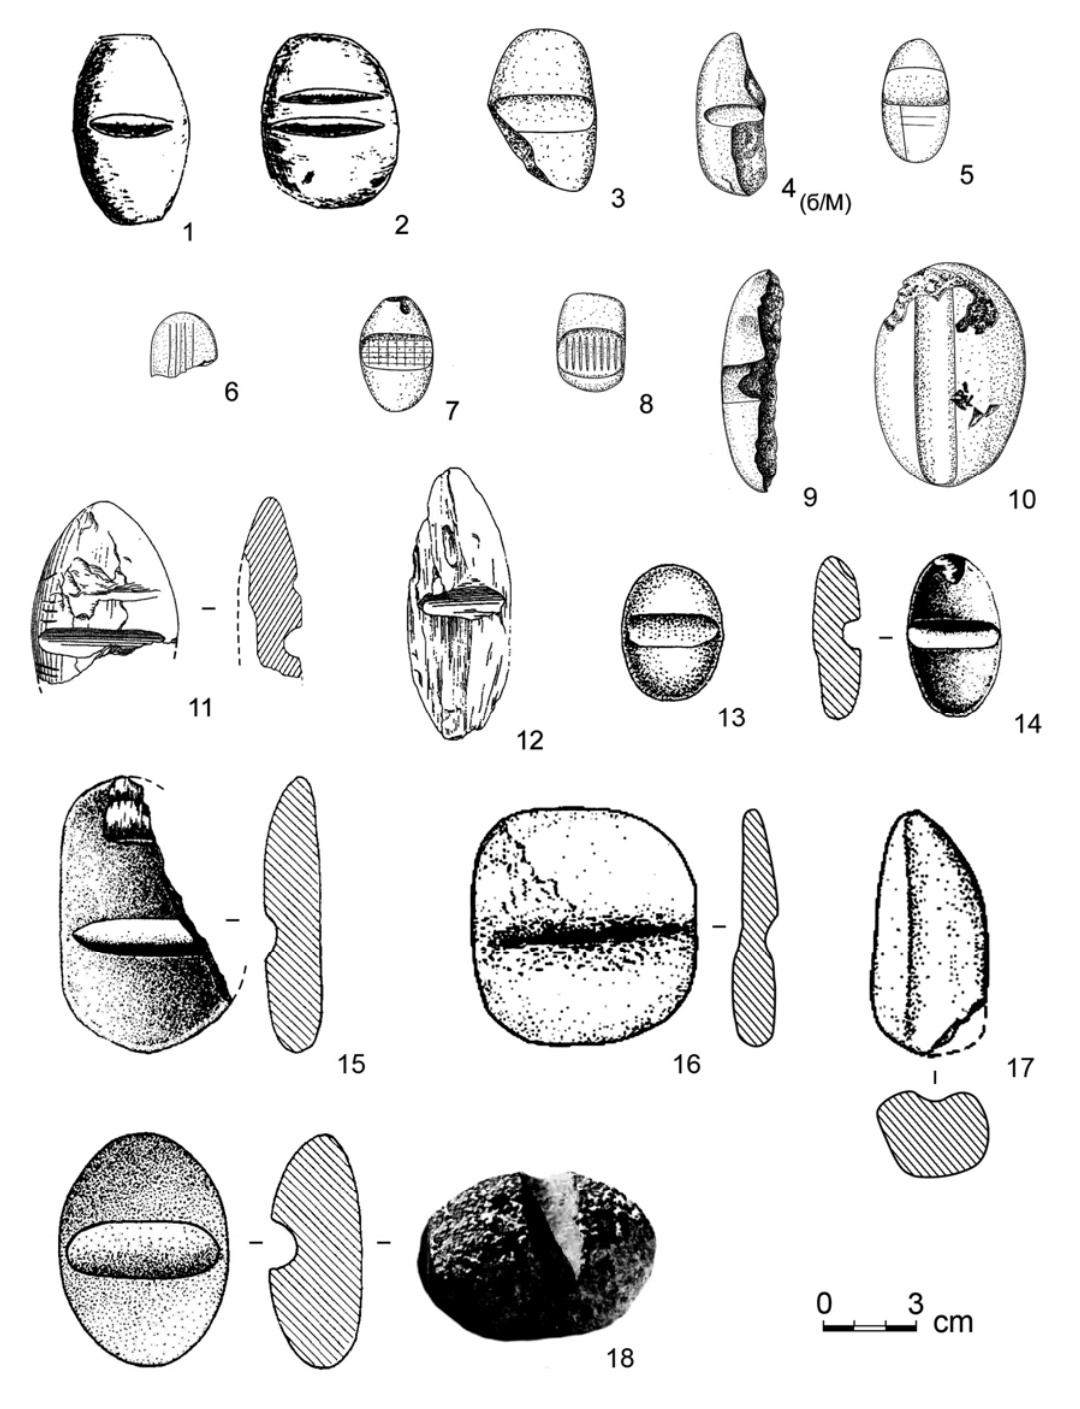
Figure 3. Epipalaeolithic through Pre-Pottery Neolithic grooved stones from the area of the Zagros Mountain and Negev Desert (Harifian Cultures). 1, 5-6: Shanidar Cave (Solecki & Solecki 1970: 833, fig. 1, D, I, L); 2-4, 7-10: Zawi Chemi Shanidar (Solecki & Solecki 1970: 833, fig. 1, A, B, C, E, F, G, H); 11-13: Karim Shahir (Howe 1983 fig. 12, 1, 2); 14-15, 18: Jarmo (Moholy-Nagy 1983: fig. 131, 12-14; fig. 140, 7); 16-17: Abu Salem, Harifian (Goring-Morris 1991: 197, fig. 16, 5,